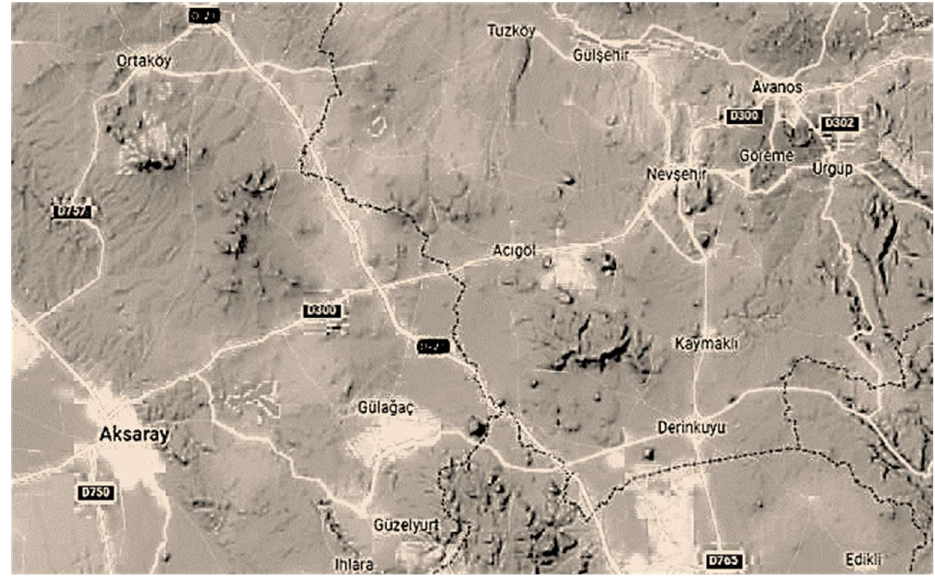
Figure 1. A map of the towns in Cappadocia taken from Google Maps. A similar map has been used by Öztürk [3], p.137.